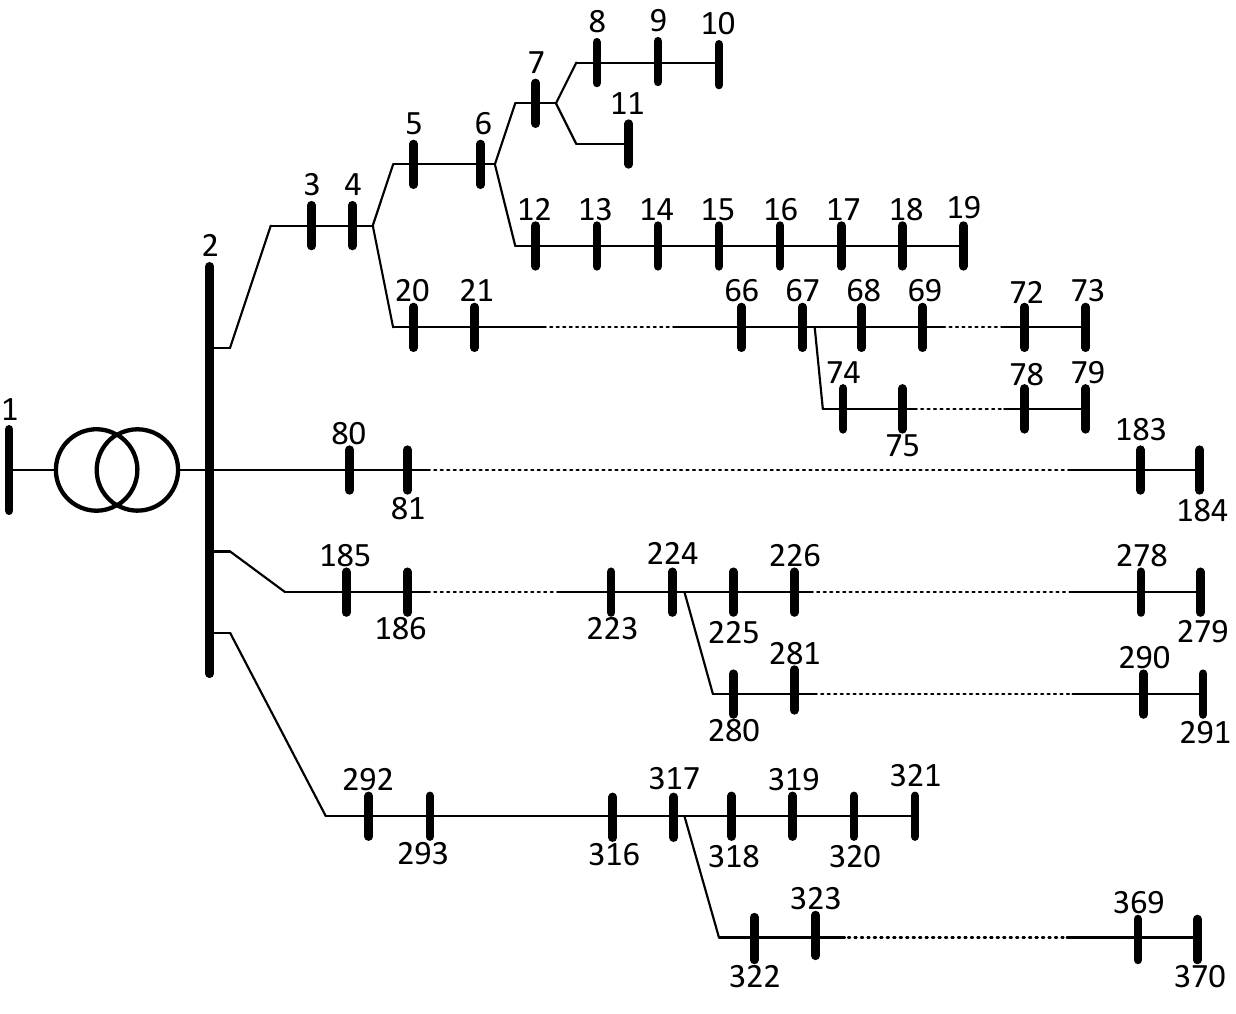
Figure 6. Schematic of Urban LV network.